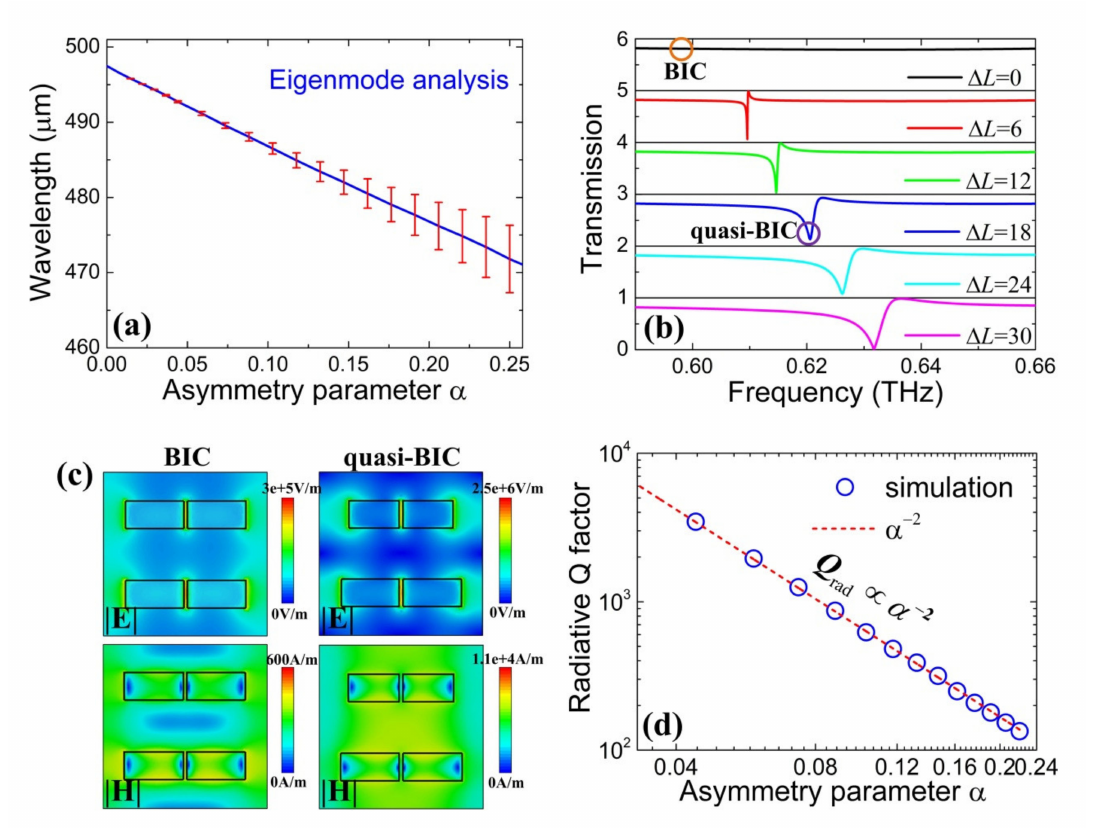
Figure 3. ( a ) Eigenmodes spectra with incident wavelength and asymmetry parameter α . Error bars show the magnitude of the mode inverse radiation lifetime. ( b ) Transmission spectra with a di ff erent length di ff erence ∆ L . ( c ) Distribution of electric and magnetic field amplitude for bound states in the continuum (BIC) and quasi-BIC labeled ( b ). ( d ) Radiative Q -factor of quasi-BIC with asymmetry parameter α